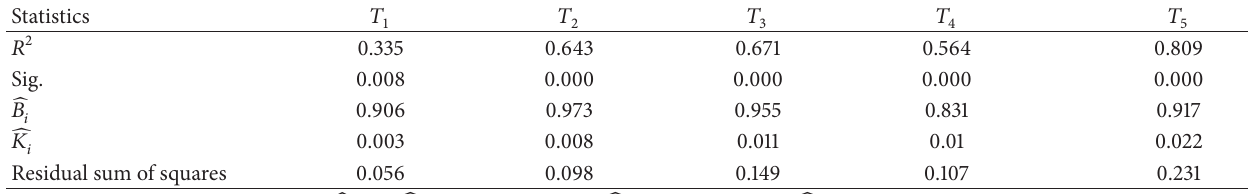
Table 2: Analysis for two-step method.